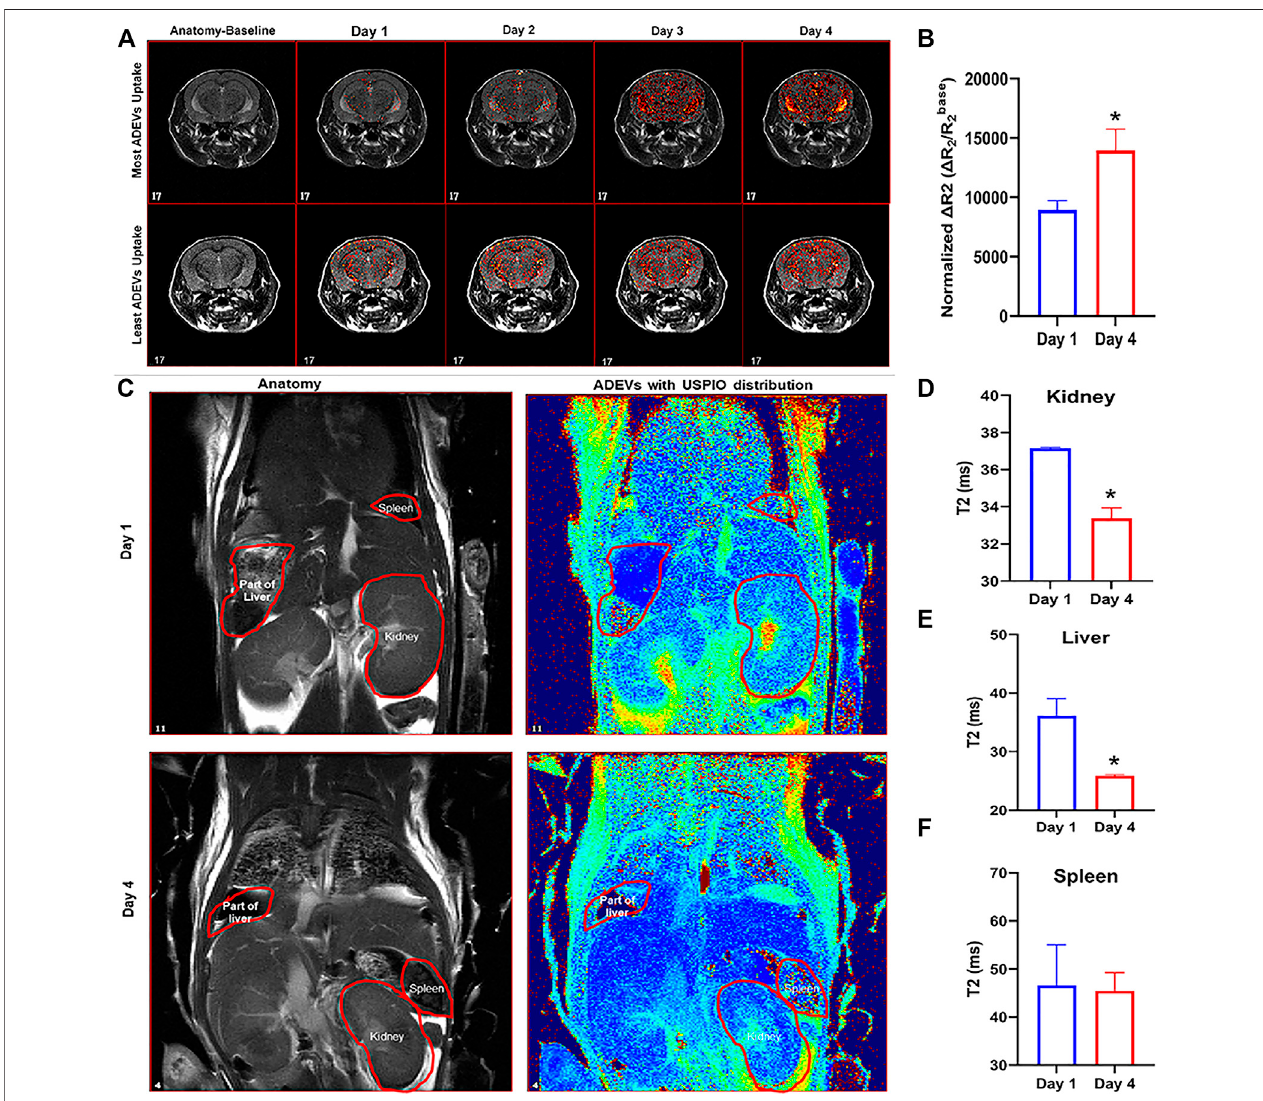
FIGURE 2 | Biodistribution of USPIO-labeled ADEVs in mice. (A) MRI T2-weighted images showing the USPIO-labeled ADEVs were present in the brain, and their abundance increased with each intranasal perfusion. (B) Quanti fi cation of the USPIO-labeled ADEVs in the brain; the bar graph shows the sum of normalized Δ R2 (i.e., Δ R 2 /R 2base ) ofall pixelsin brainR 2 maps, and valueincreases along with time. (C) MRI T2-weighted images showing the USPIO-labeled ADEVswere present in the (D) kidneys, (E) liver, and (F) spleen.